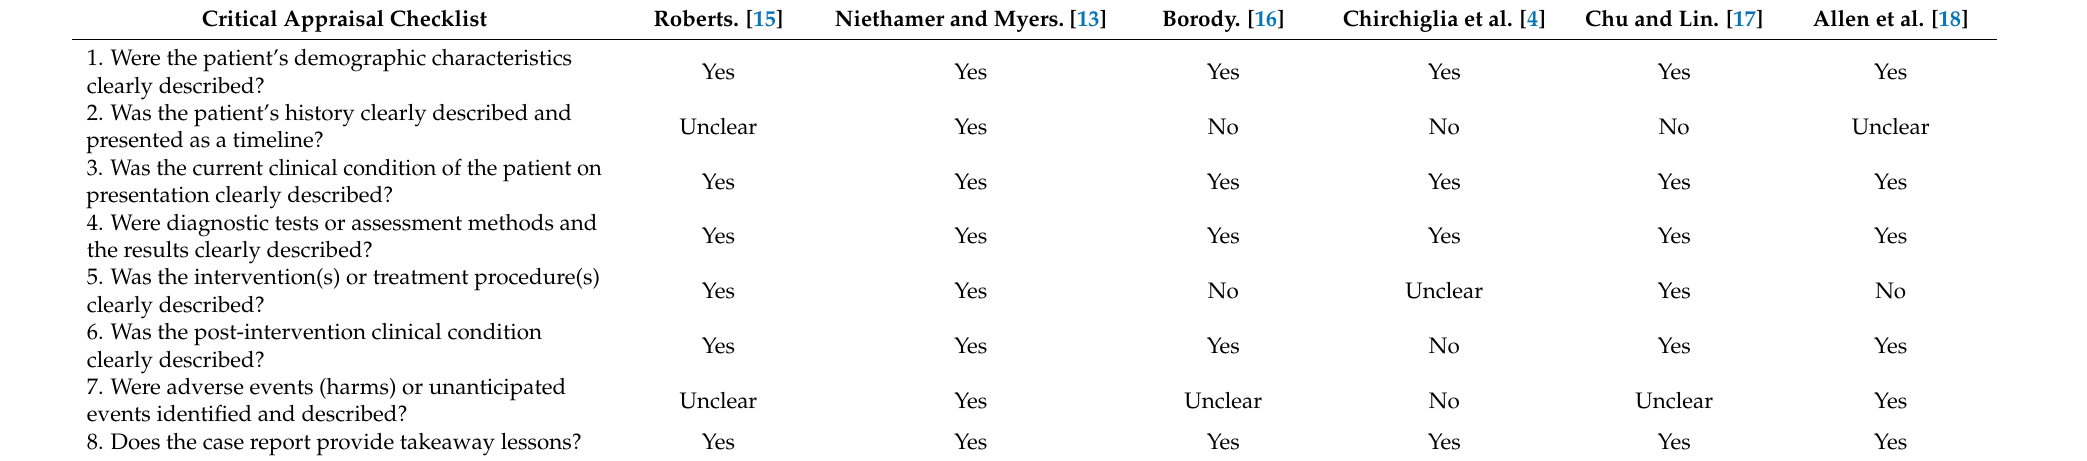
Table 1. Critical appraisal checklist for case